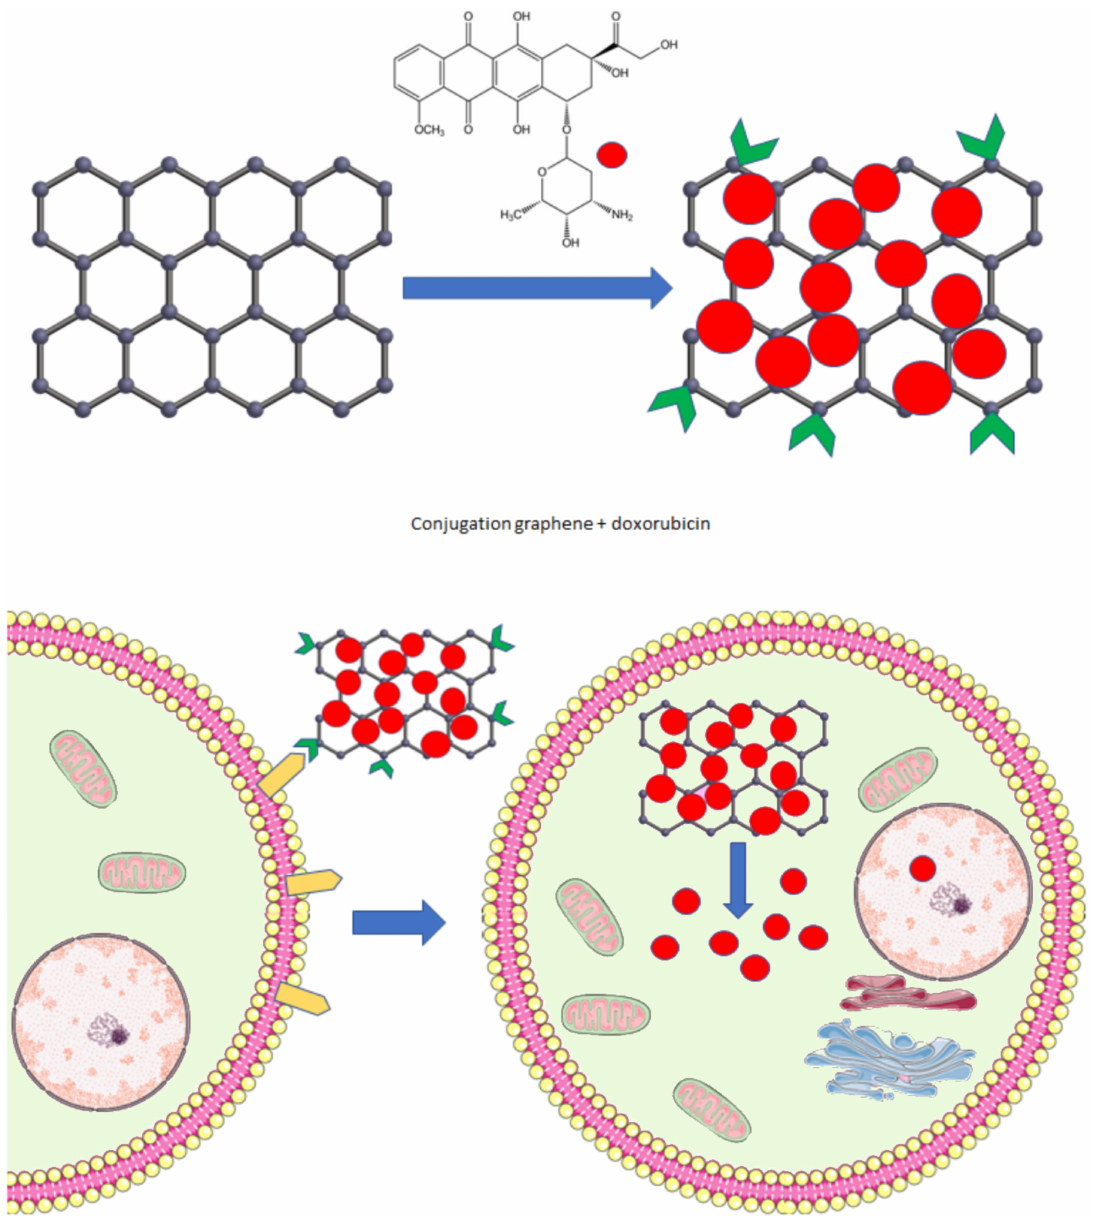
Figure 4. NCP drug delivery system. Graphene conjugated with doxorubicin and a receptor specific for antigens expressed primarily on the target cell. The loaded graphene interacts with the cell membrane, enters the cell, and releases the drug (parts of the figure were drawn using pictures